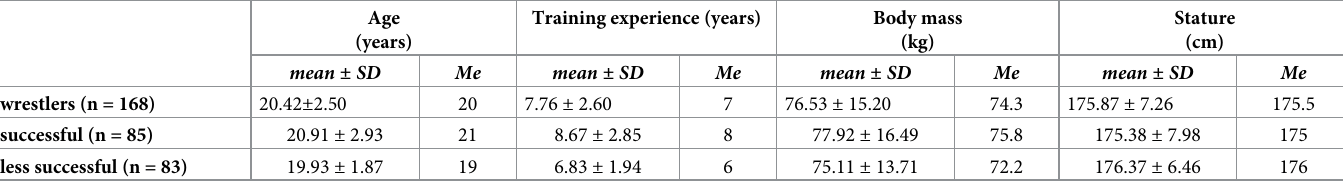
Table 1. Characteristics of the research group (mean ± SD , Me)